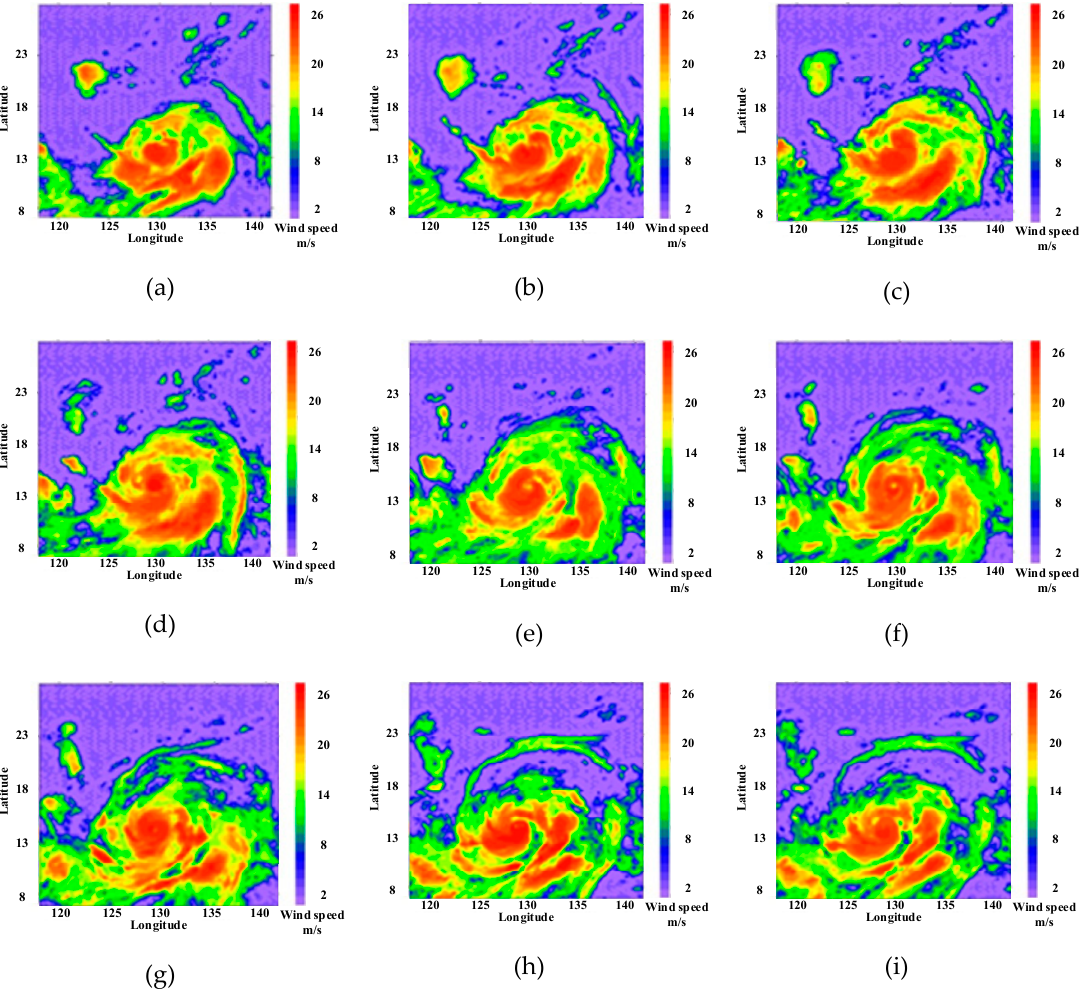
Figure 7. The sea surface wind field of Usagi at different times: ( a ) 1:00; ( b ) 3:00; ( c ) 5:00; ( d ) 7:00; ( e ) 11:00; ( f ) 13:00; ( g ) 15:00; ( h ) 17:00; ( i ) 20:00. Table 3. The metrics results for typhoons Usagi, Fitow, and